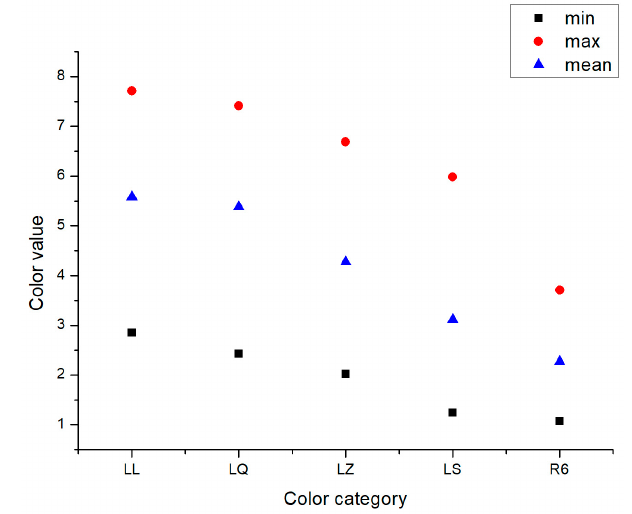
Figure 6. The distribution of color values of each cell in each color category.